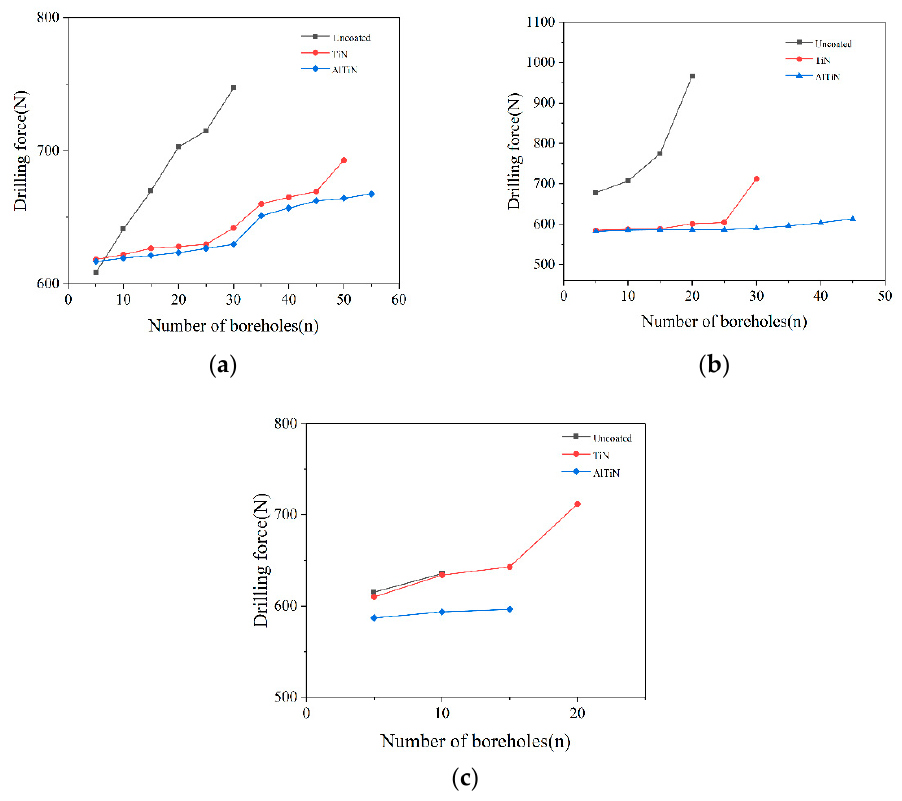
Figure 4. Drilling force curve (Feed speed of 0.04 mm/r). ( a ) Drilling speed of 15 m/min. ( b ) Drilling speed of 20 m/min. ( c ) Drilling speed of 25 m/min.